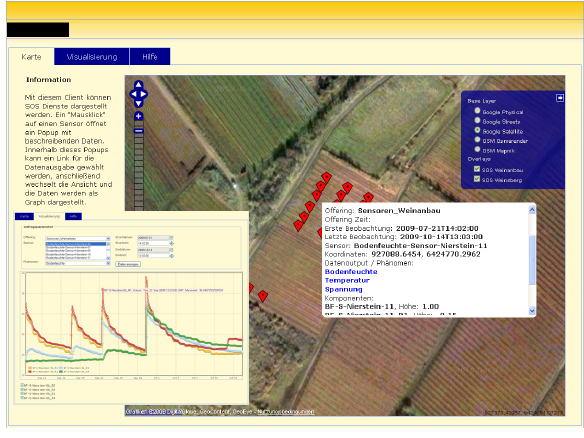
Figure 7. Web client using “OpenLayers” extended by SOS functionality.